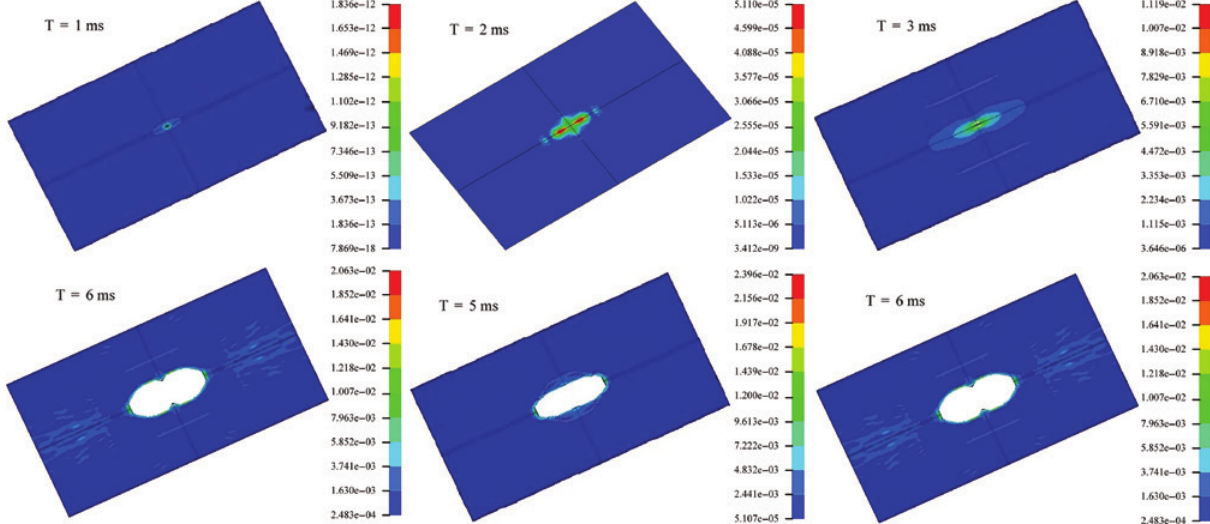
Figure 12: The damage of the adhesive layer.